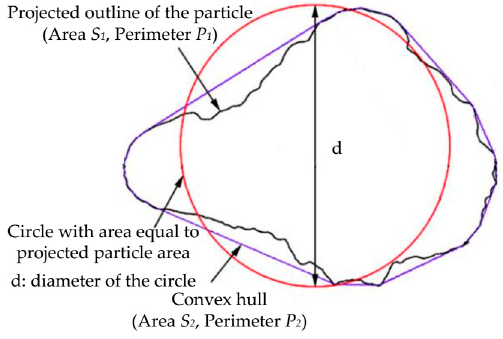
Figure 4. Basic measurements of a particle [35].